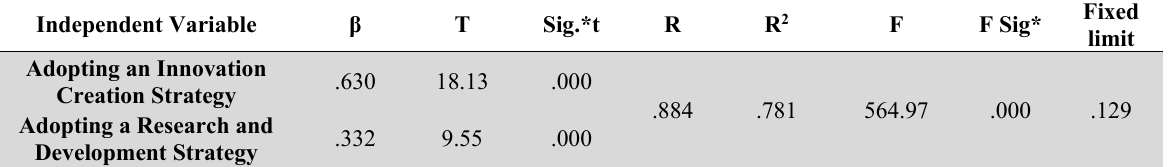
Multiple Regression Analysis to find out the impact of strategic innovation on business sustainability in the Jordanian tour- ism sector Independent